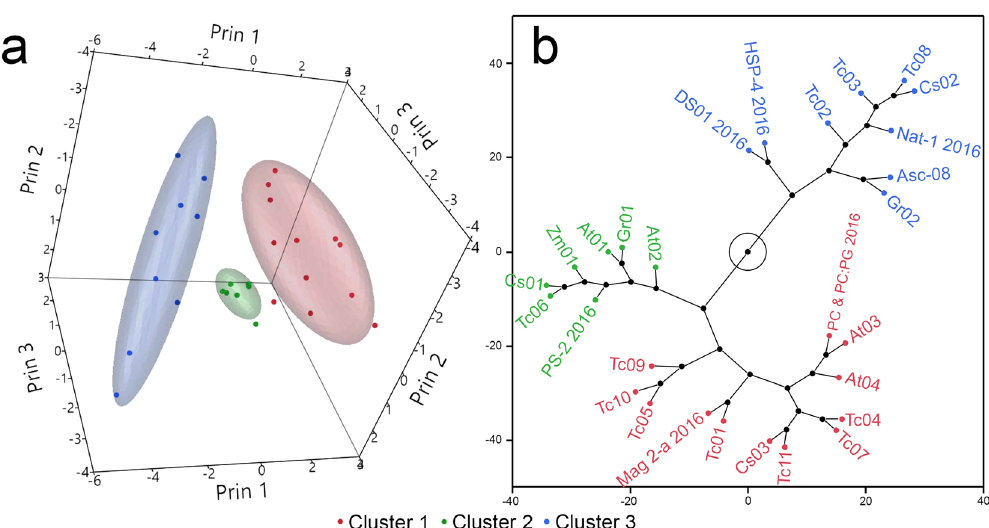
Figure 2. Multivariate statistics reveals similarities in peptide-induced perturbation of the main phase transition of model membranes probed by differential scanning calorimetry. A matrix describing the effect of peptides (Table 1, 2016 set) in the transition temperature (Tm), enthalpy ( Δ H) and cooperativity ( Δ H VH ) of the broad and sharp components of DMPC and 2 ∶ 1 DMPC:DMPG LUV thermograms was assembled and standardized (Supplementary material 01). A principal component analysis was applied to the resulting data and the first five principal components, which explain ~87% of the data variance, were recorded (Supplementary material 01). A hierarchical clustering analysis (HCA) algorithm was applied to peptide locations in the first five principal components. ( a ) 3-D scatterplot of the peptide positions on the first three principal components. Peptide clusters, obtained from HCA, are color coded: Cluster 1, in red, cluster 2, green, cluster 3, blue. Normal contour ellipsoids (coverage 0.66) were calculated for peptide clusters. ( b ) Constellation plot of the dendrogram obtained from HCA categorizes peptides in discrete clusters. Cluster identities are represented by the same color